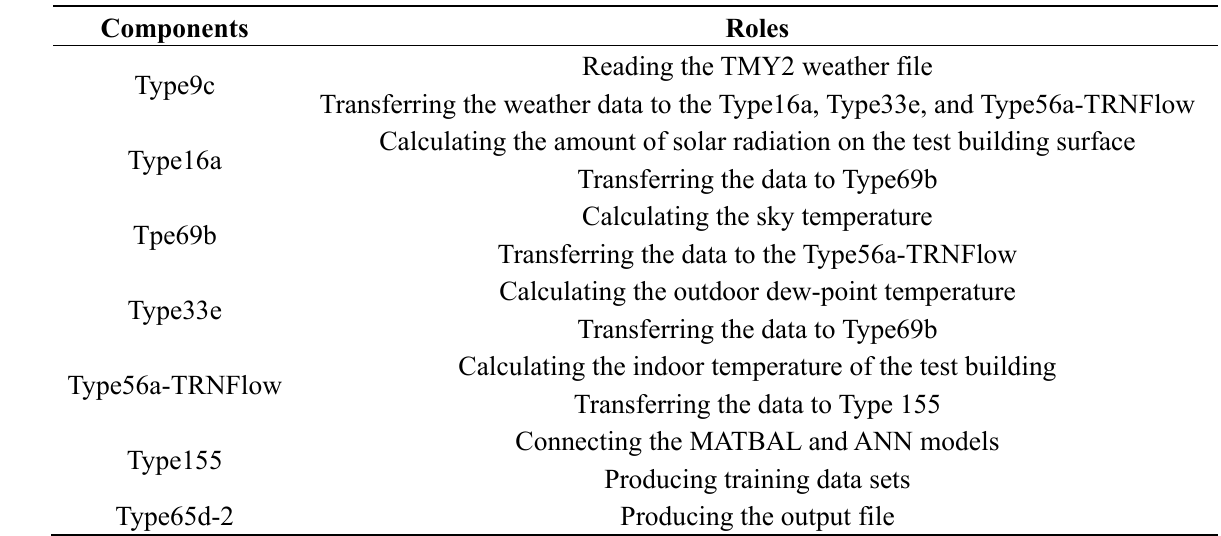
Table 3. Roles of the TRNSYS components.